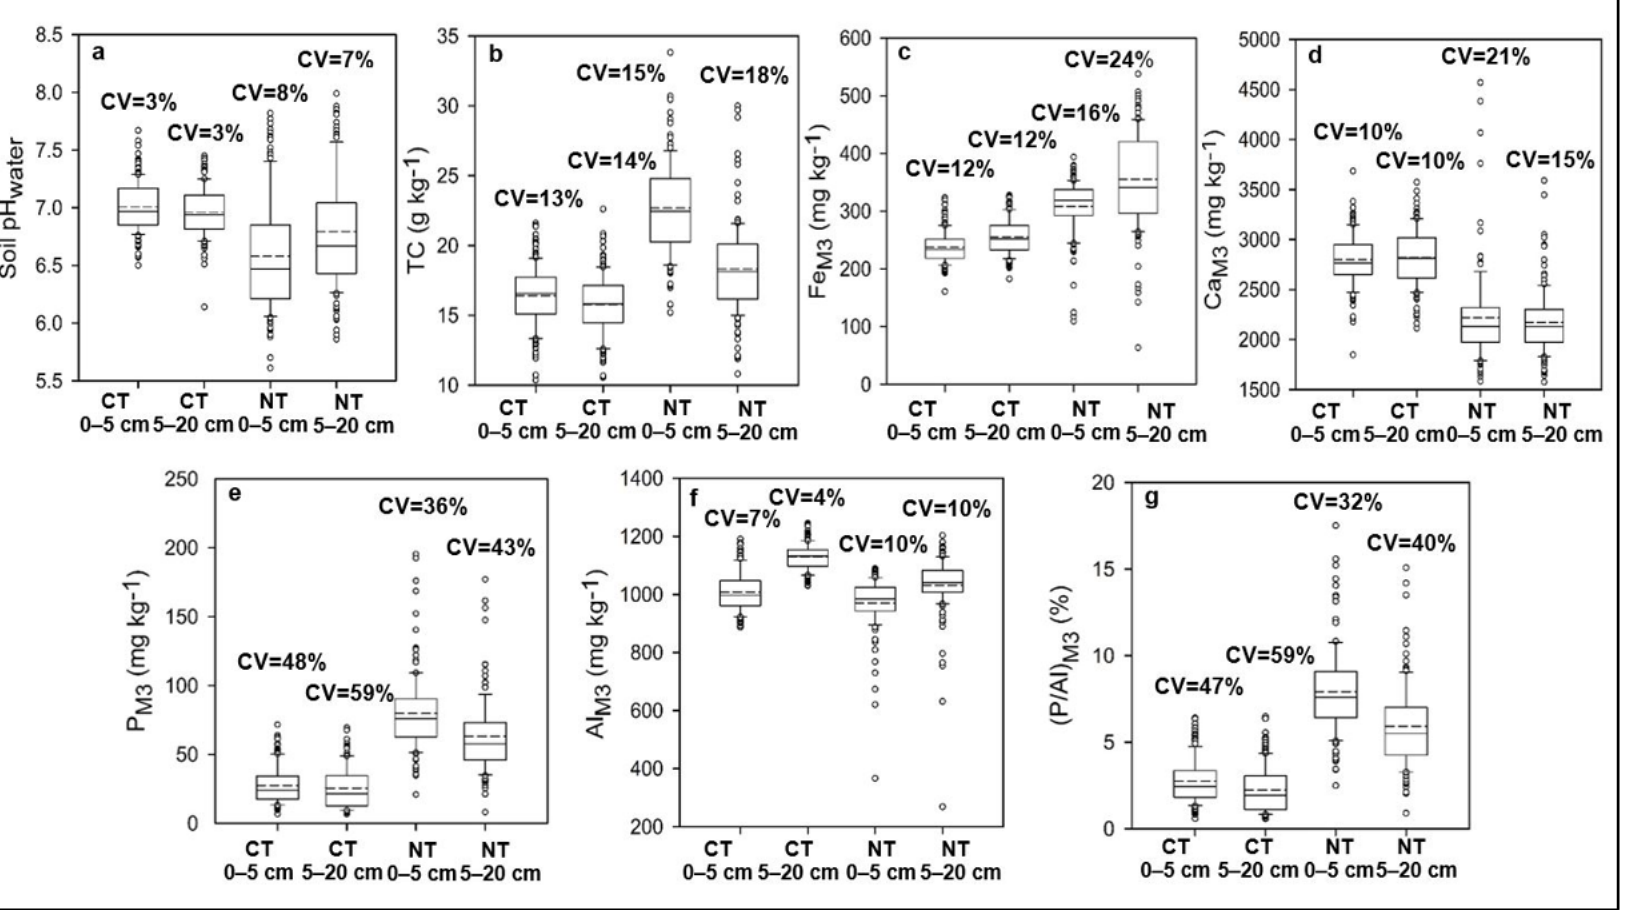
Figure 2. Descriptive statistics of soil pH H2O ( a ), TC ( b ), Fe M3 ( c ), Ca M3 ( d ), P M3 ( e ), Al M3 ( f ) and (P/Al) M3 ( g ) for two soil layers (0–5 cm and 5–20 cm) in the conventional and no-tillage fields.